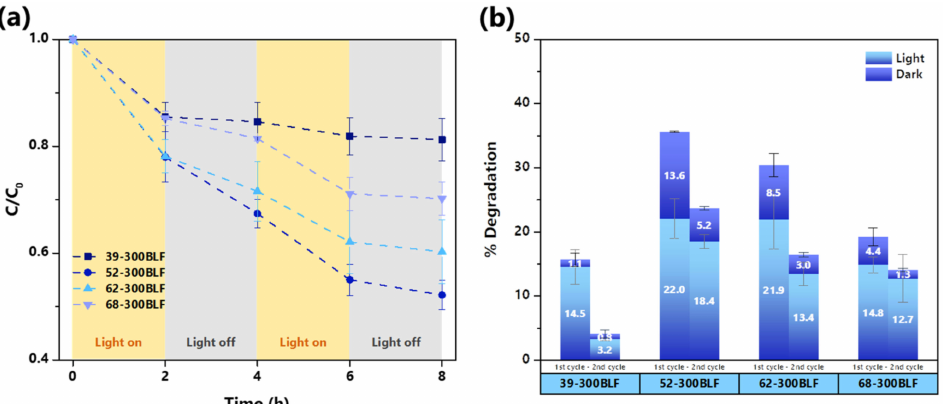
Figure 7. Photocatalytic degradation of four different NiO loading BLF catalysts by: ( a ) relative concentration over time and ( b ) degradation in light and dark conditions for each cycle.